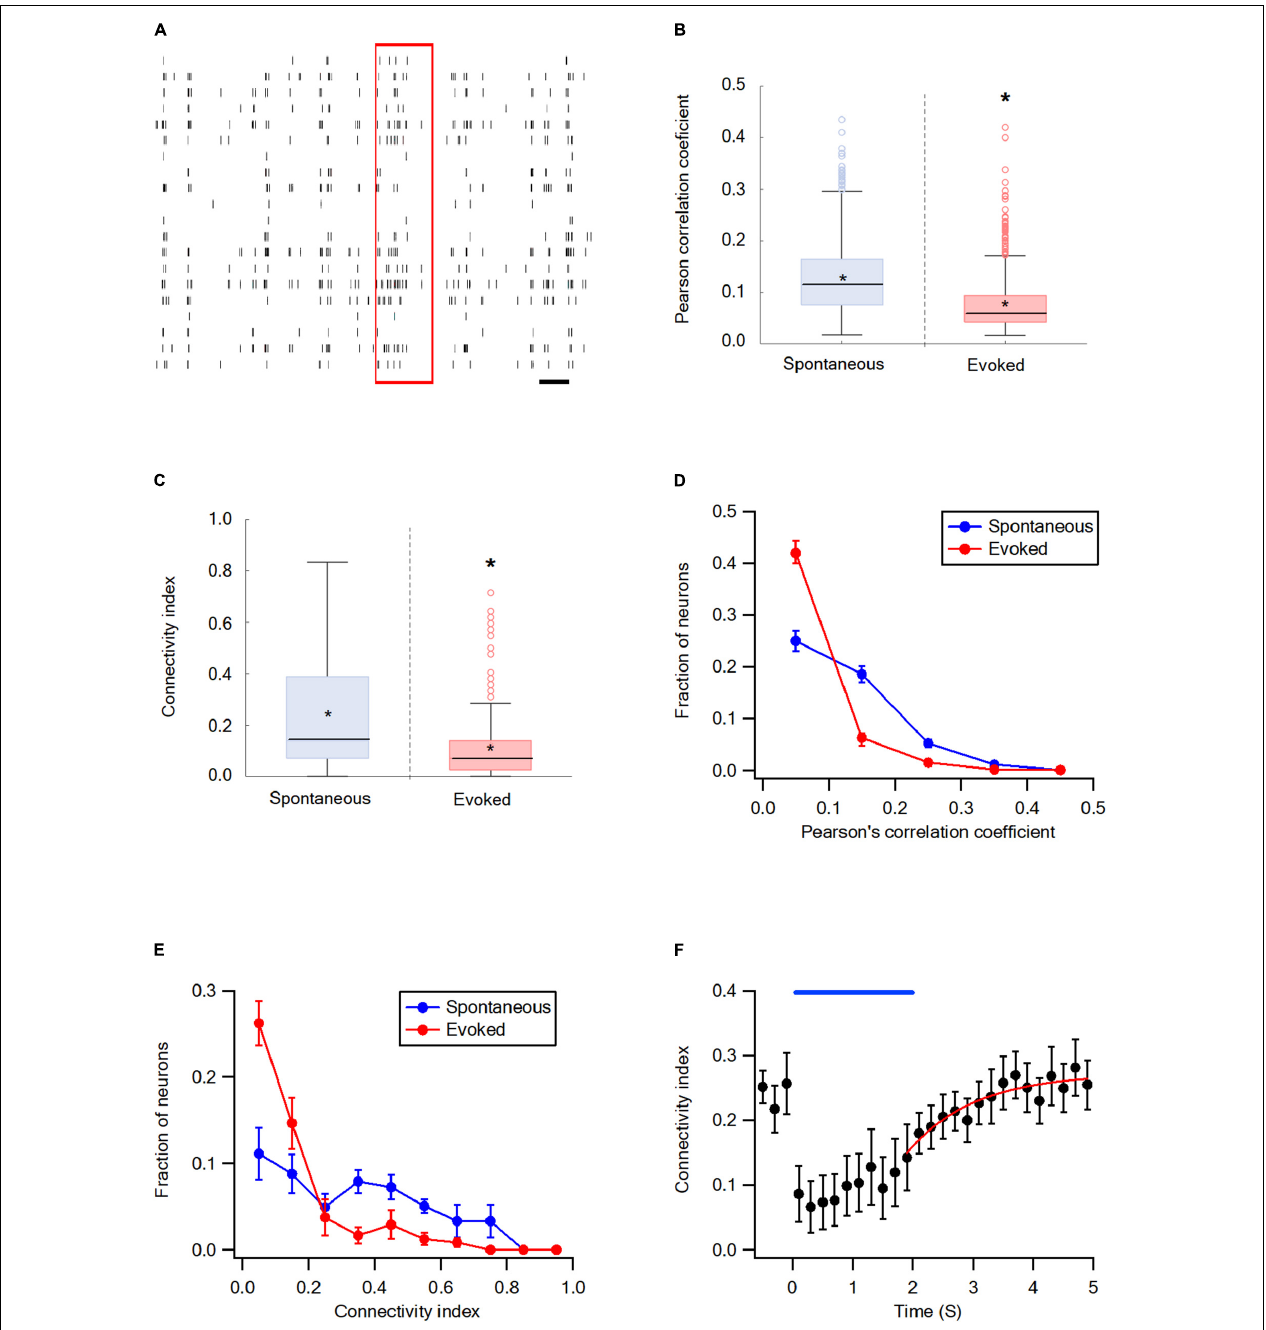
FIGURE 4 | Desynchronization during evoked activity in the wS2 cortex. (A) Raster plots an example of spike trains during the single-trial from layer 2-3 neurons in the S2 cortex. The red rectangle represents the stimulus and the black scale bar represents 1 second. (B) Box plots of the Pearson’s correlation coefficient during spontaneous and evoked activity states (207 units from 6 rats). The middle line in the boxplots represents the median value and the asterixis represents the mean value. A value of * p < 0.05 was obtained with the t -test. (C) Box plots of the average connectivity index during spontaneous and evoked activity states. The middle line in the box plots represents the median value and the asterixis represents the mean value. A value of * p < 0.05 was obtained with the Mann-Whitney non-parametric test. (D) Histograms showing the average fraction of wS2 neurons ( M ± SEM ) with different Pearson’s correlation coefficient values during spontaneous and stimulus-evoked activity states. Comparison of the spontaneous and evoked histograms during both passive ramp-and-hold and artificial whisking yielded p < 0.001 using the X 2 statistical test. (E) Histograms showing the averaged fractions of neurons ( M ± SEM ) with different connectivity index values during spontaneous and stimulus-evoked activity states. Comparison of the spontaneous and evoked histograms during both passive ramp-and-hold and artificial whisking yielded p < 0.001 using the X 2 statistical test. (F) The averaged connectivity index ( M ± SEM ) in wS2 as a function of time before, during, and after artificial whisking mediated whisker activation (172 units from 5 rats). A mono-exponential function was fit to the graph with a time constant of 1.29 ± 0.3 s.